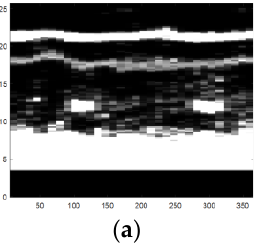
Figure 13. The defect images processed by the Laplacian operator: ( a ) small crack, ( b ) transverse crack, ( c ) hole defect, and ( d ) chapped defect.